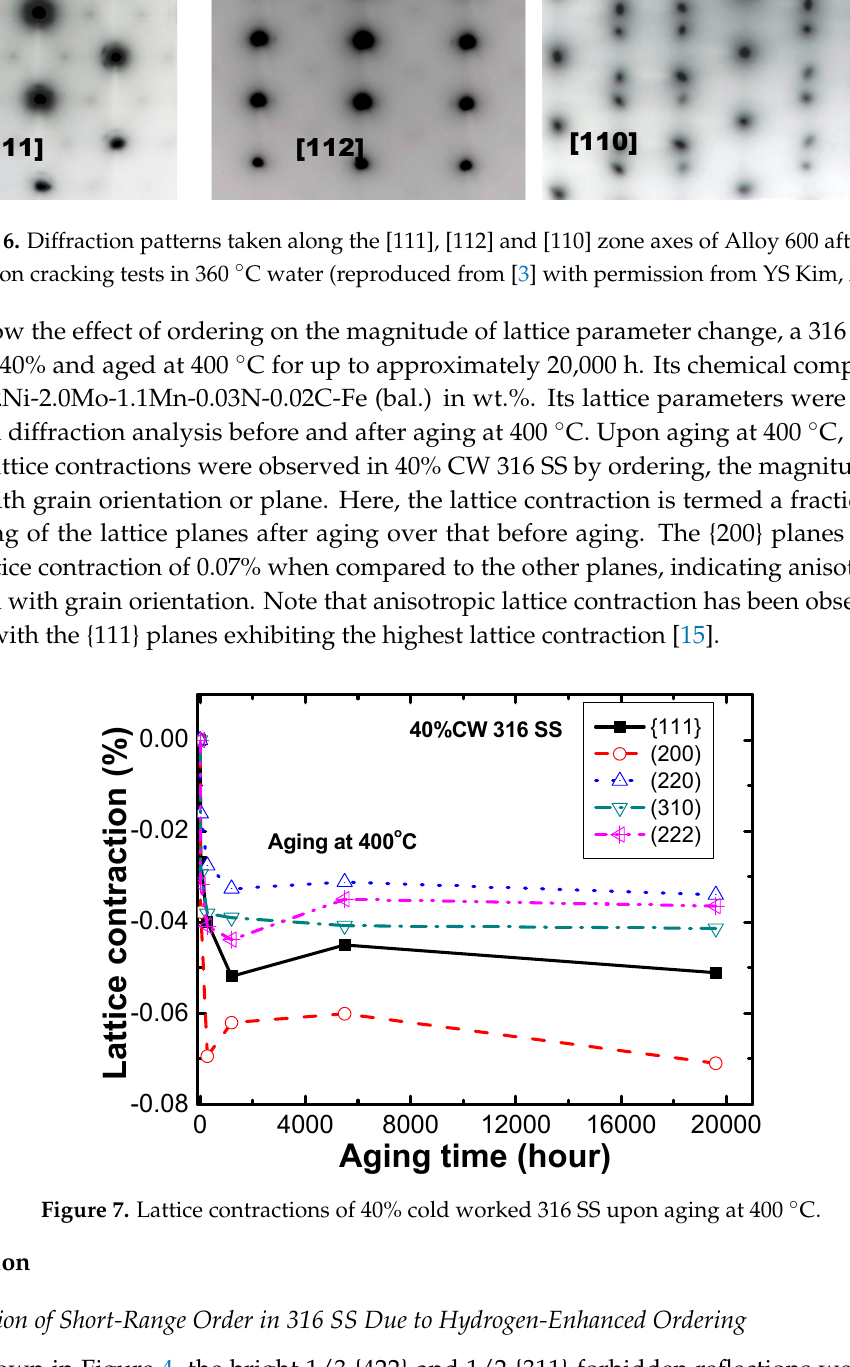
Figure 5. Twinning spots and streaks ( a,c ) observed when the planar dislocations ( b,d ) formed on the fracture surfaces of a 316 SS deformed in hydrogen ( a,b ) and air ( c,d ), respectively, were examined in the [110] zone axis. ( b,d ) added intentionally to show the twin streaks aligned perpendicular to planar dislocation boundaries (reproduced from [8] with permission from BH Choe, 2019).